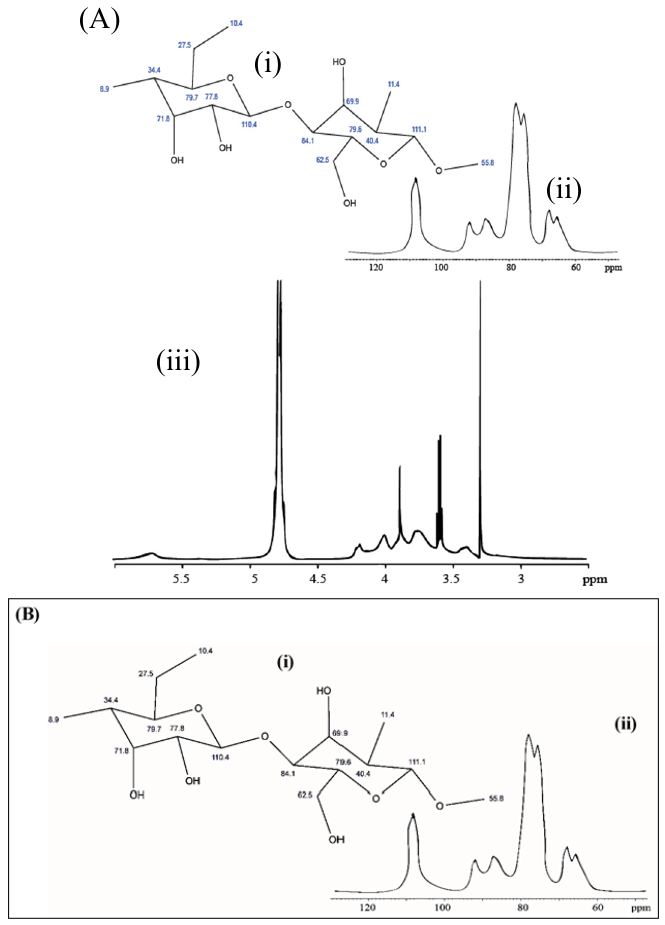
Figure 6. ( A ) ( i ) CMSC structure; ( ii ) 1 H ‐ NMR and ( iii ) 13 C ‐ NMR spectra of CMSC (DS = 0.6) in D 2 O ( iv ) Contour plots of COSY spectra of CMSC (DS = 0.6) in D 2 O recorded at 343 K. and ( B ) ( i ) cellulose structure; ( ii ) 13 C ‐ NMR spectra of cellulose.